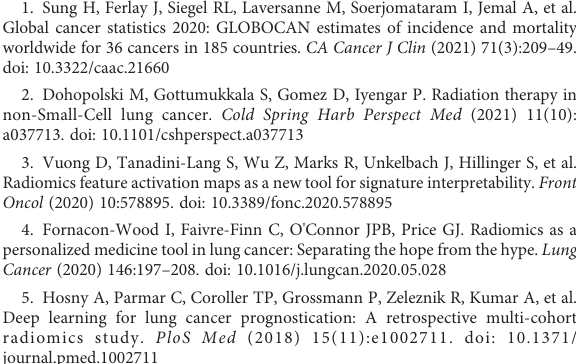
SUPPLEMENTARY FIGURE 3 ComparisonofAUCvaluesofdifferentmodelsinthetrainingsetusingDeLong ’ s test. P <0.05indicatedastatisticallysigni fi cantdifference.Rad_Score=0.1551*